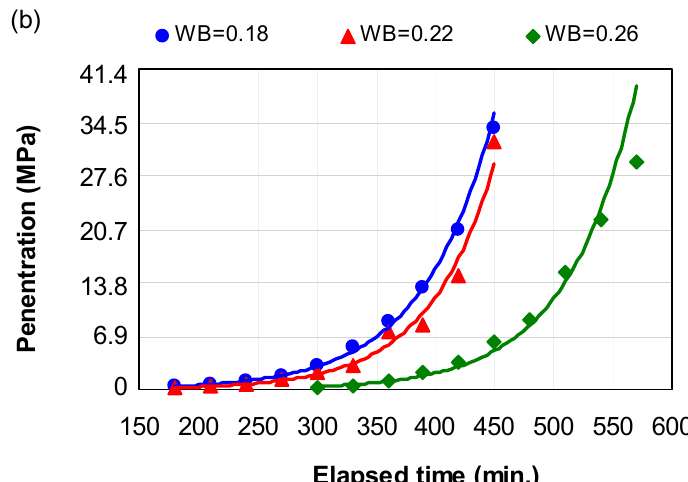
Figure 3. Penetration resistance: ( a ) effect of SF on penetration resistance (PR) for the mixtures with WB = 0.22; ( b ) effect of WB on PR for mixtures containing 20% SF.